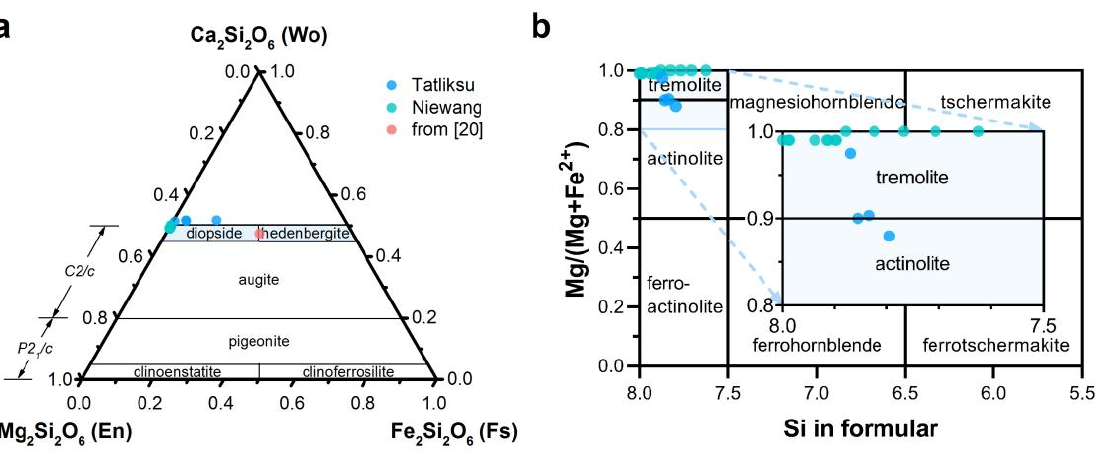
Figure 4. ( a ) Plot of the Ca‑Mg‑Fe composition of clinopyroxenes with polysynthetic twinning based on Wo‑En‑Fs (mol.) ternary classification [32]; ( b ) Classification diagram of surrounding amphiboles, after Leake et al. [33] and Hawthorne et al. [34].